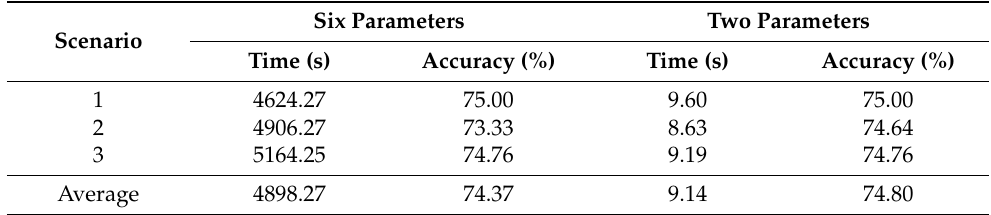
Table 7. Model’s accuracy and training time of k -NN on dataset A.